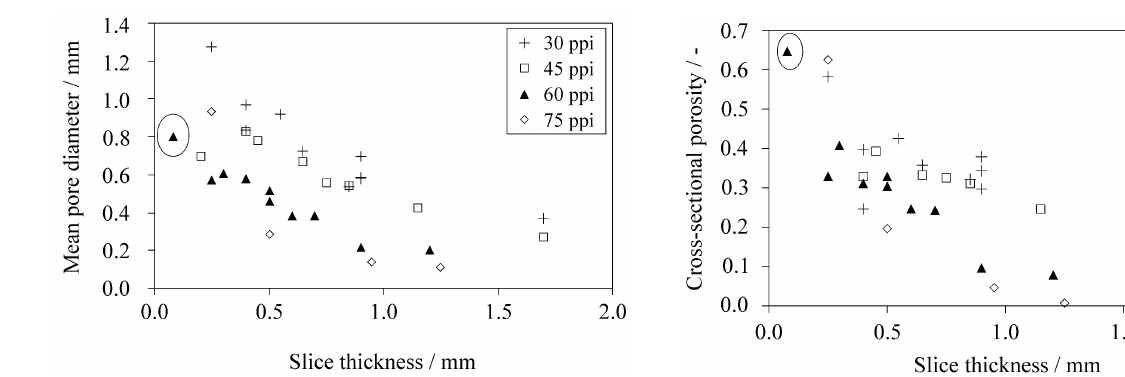
Figure 5. Influence of slice thickness on the cross-sectional porosity of SiC-Al 2 O 3 ceramic foams with 30 to 75 ppi. Circled symbol refers to the CT-image